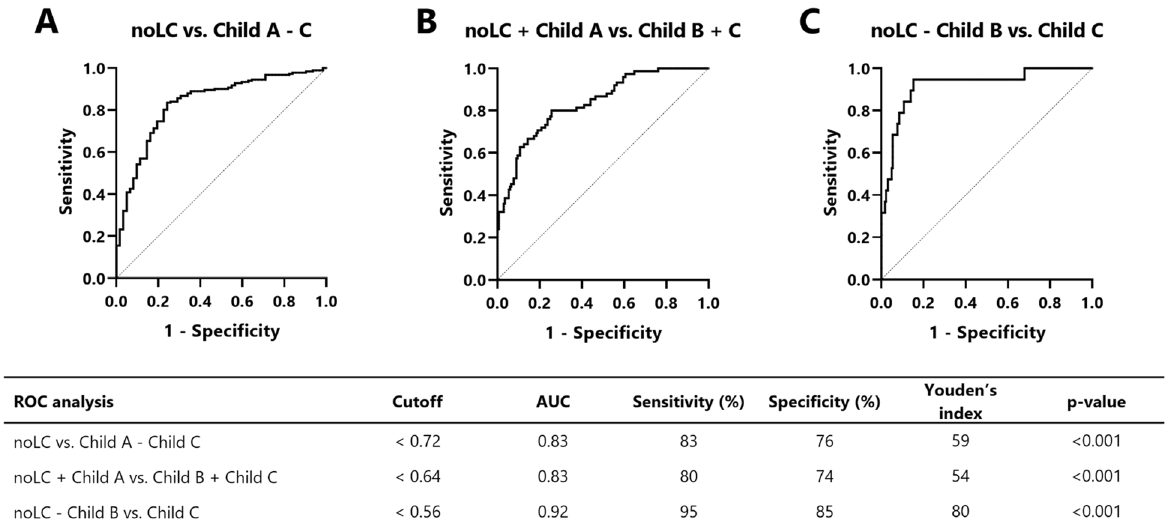
Figure 8. ROC analysis of pooled data. ROC curves for distinguishing between patients with noLC and liver cirrhosis on the basis of T1 reduction rates at 1.5 + 3 T are shown ( A – C ). AUC values for a given cutoff for each comparison as well as the sensitivity, specificity and p-values are shown. Cutoffs were determined using the Youden’s index, which is also shown. noLC no liver cirrhosis, ROC receiver operation